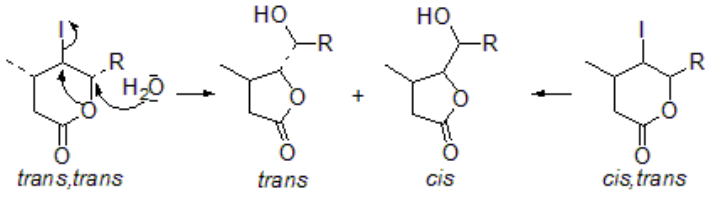
Figure 3. The translactonization mechanism of γ -iodo- δ